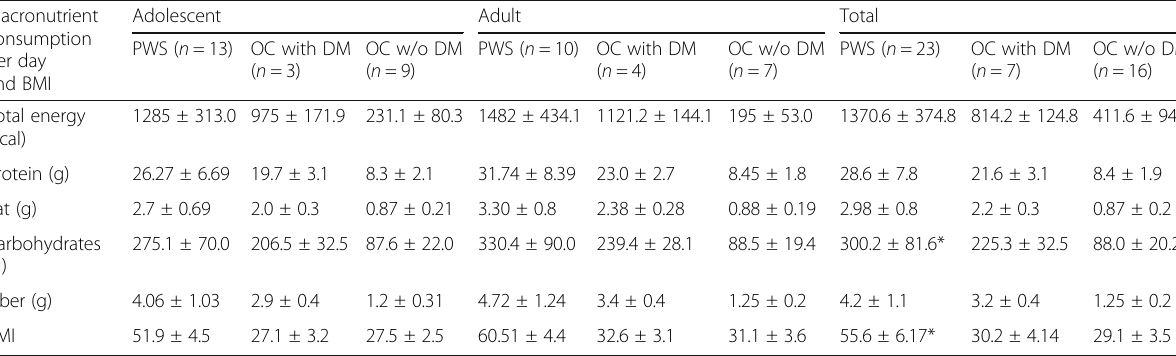
Table 4 Comparison of macronutrient consumption from white rice intake and BMI value in both PWS and OC subjects